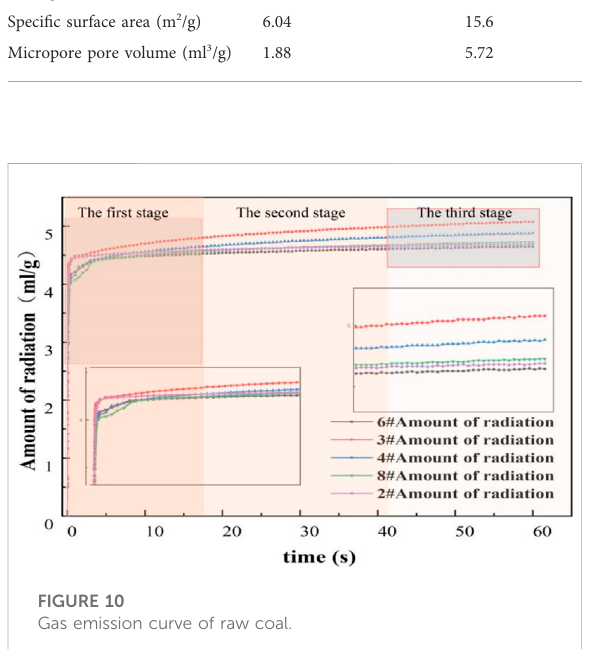
FIGURE 10 Gas emission curve of raw